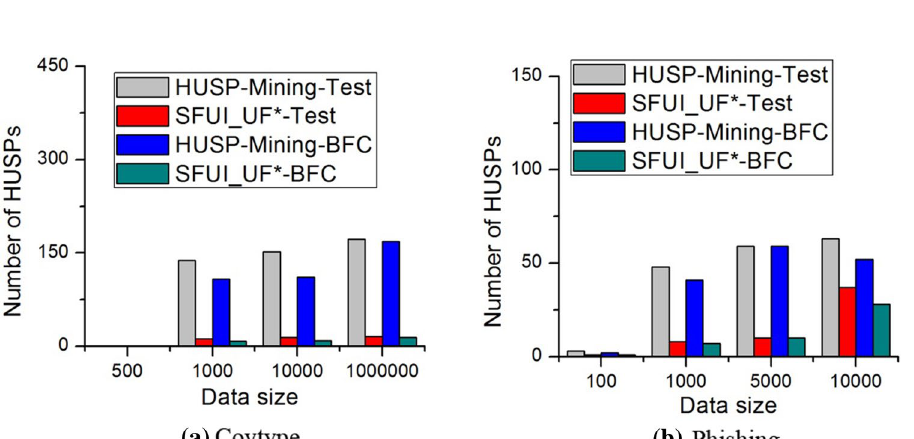
Fig.10 Number comparisons of HUSPs on different data